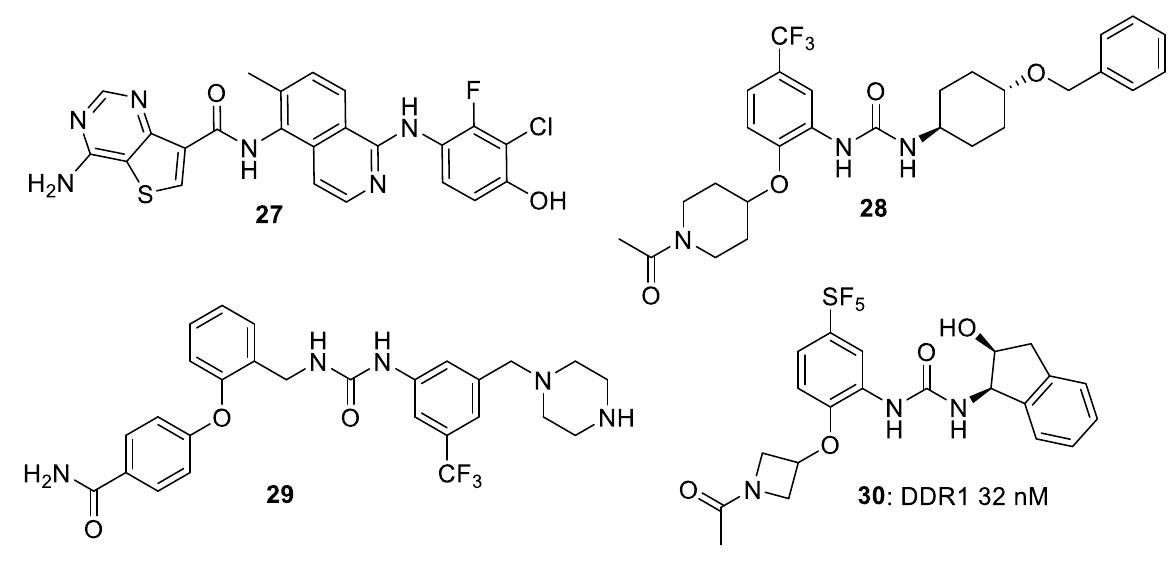
Figure 6. DDR inhibitors in the patent literature.